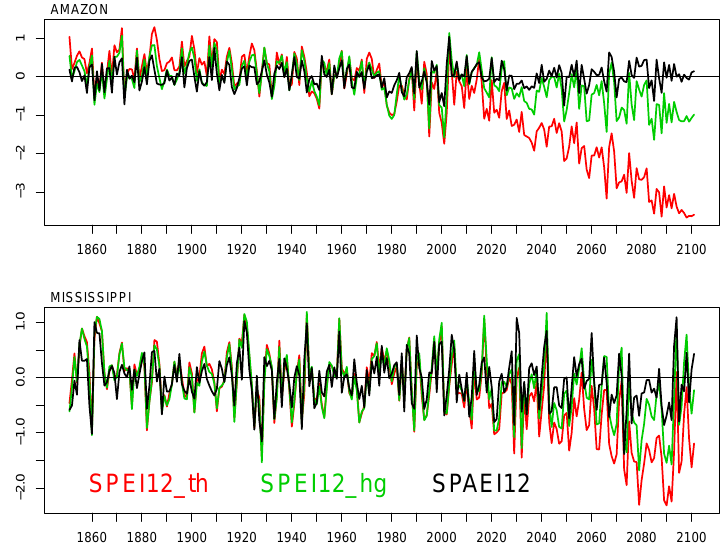
Fig. 4. Raw SPEI12 time series averaged over the Amazon (upper panel) and the Mississippi (lower panel) watersheds for one member of the CNRM-CM5 1850–2100